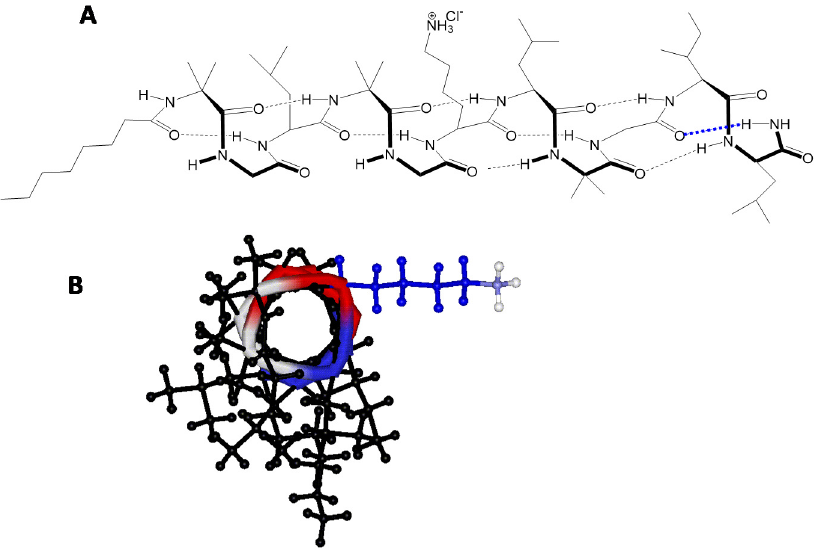
Figure 1. K6-NH2 structure. ( A ) The helical structure of K6-NH2 is strengthened by the presence of an additional H-bond, highlighted in blue. ( B ) Three-dimensional structural model for K6-NH2. The natural—albeit weak—amphiphilic structure of native peptaibol is enhanced by the presence of a Lys residue on the hydrophilic face (Lys side chain is highlighted in blue).